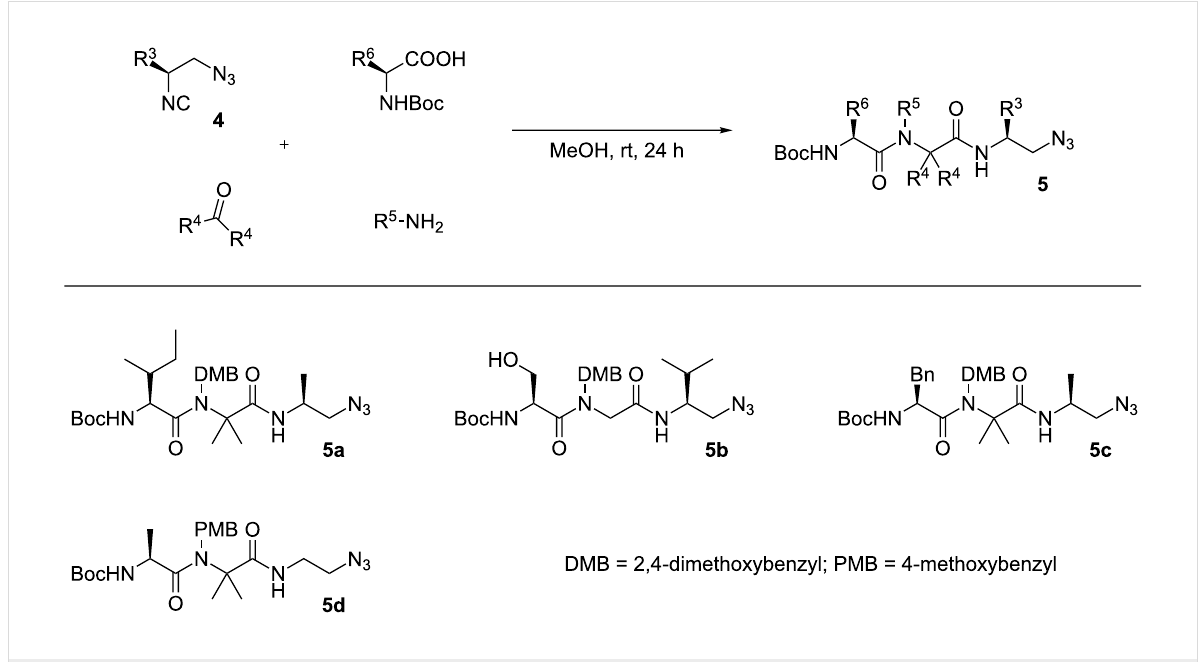
Scheme 2: Synthesis of peptides 5 through the Ugi